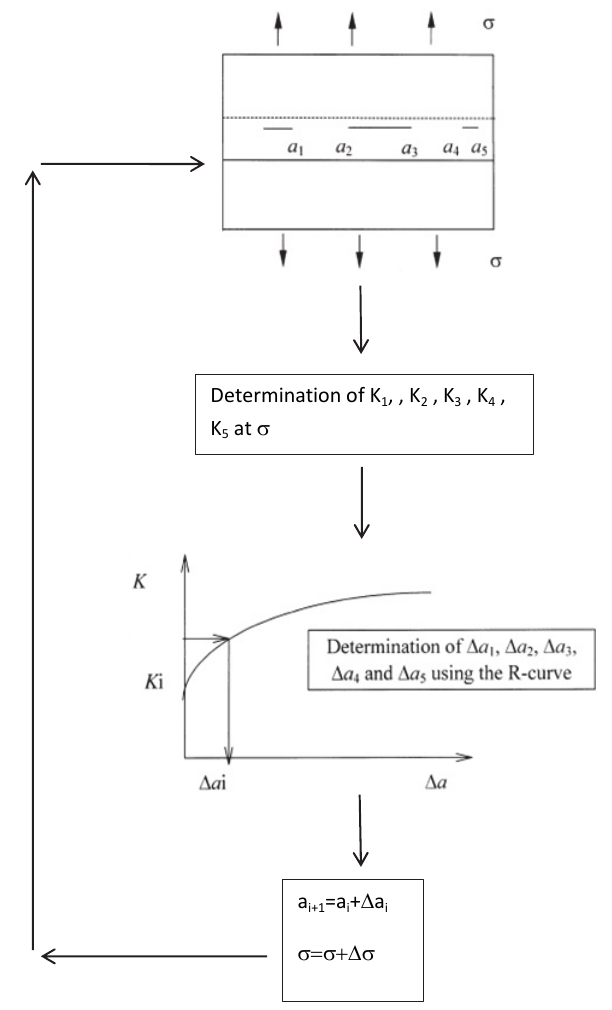
Figure 5: Flow chart of residual strength assessment procedure.